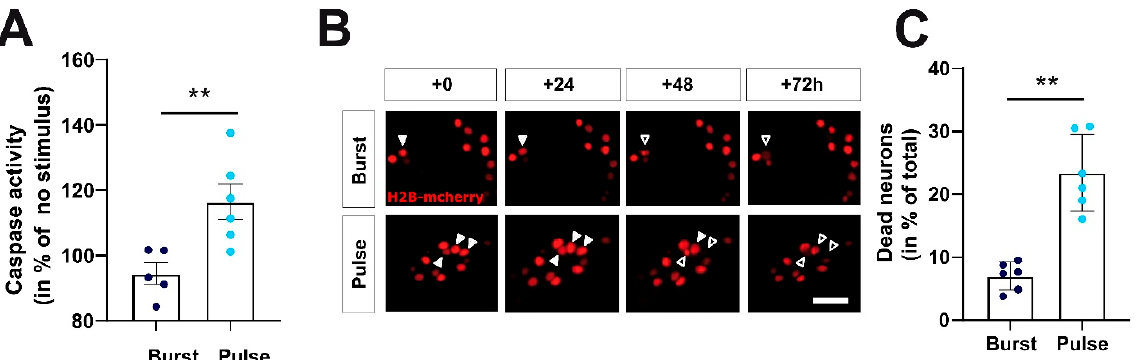
Figure 6. Optogenetically provoked changes in firing patterns critically regulate caspase activity and neuronal cell death rates during late development. ( A ) After 48 h of continuous optogenetic stimulation with the burst pattern caspase activity was lower as compared to optogenetic stimulation with pulse pattern ( n = 5/6 cultures; p < 0.01). ( B ) Representative images of H2B-mCherry positive nuclei subjected to optogenetic burst and pulse stimulation over the time course of the experiment. Filled arrows mark cells that died during the time course of the experiment. Unfilled arrows mark apoptotic or dead neurons, respectively. ( C ) Statistical analysis revealed that significantly more neurons are dead after 72 h if cultures were stimulated with pulse pattern compared to stimulation with physiological burst pattern ( n = 6/6 cultures, p = 0.002). Scale bar represents 50 µm. ** indicates p -values <0.01.